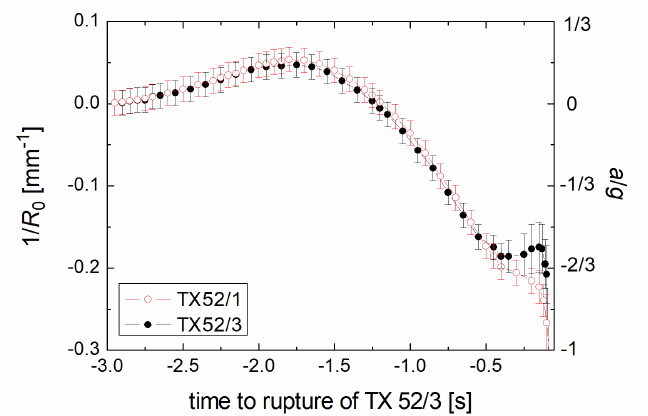
Figure 9. Inverse radius of curvature (1/ R 0 ) and the corresponding lateral acceleration a , as calculated using Equation (3). During the final 300 ms before rupture, the deformation was already asymmetric and this model did no longer